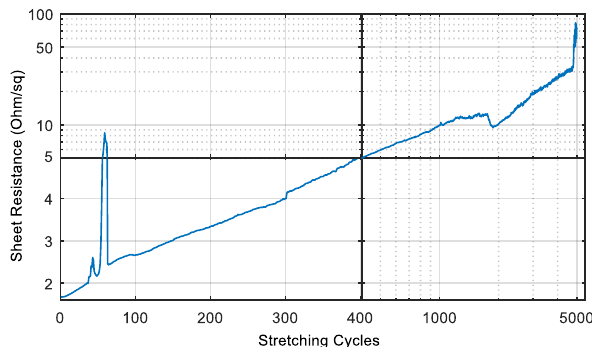
Figure 6. The sheet resistance of the inkjet-printed silver wires after two days of relaxation during the cyclic stretching test.